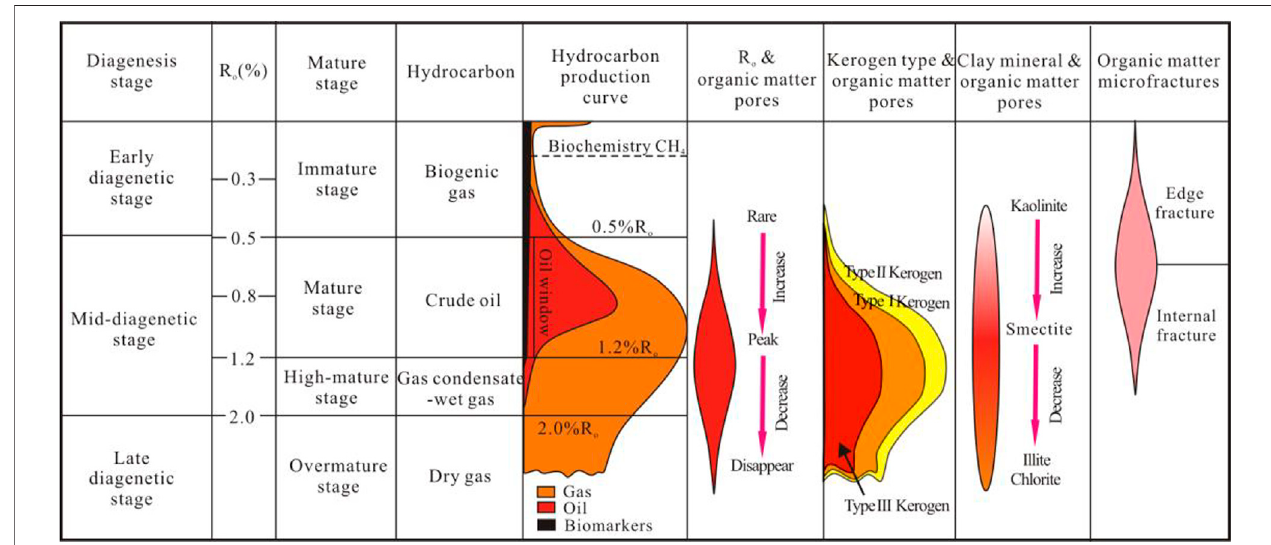
FIGURE 12 | In fl uence of thermal maturity-related parameters on the development degree of shale organic matter pores. With the increase of R o , during the early- to-mid mid-diagenesis period, the microfractures were developed. In the mid-to-late mid-diagenesis period, the organic matter was in the mature-over-mature stage, a large number of organic matter pores were formed and the organic matter microfractures disappeared gradually.